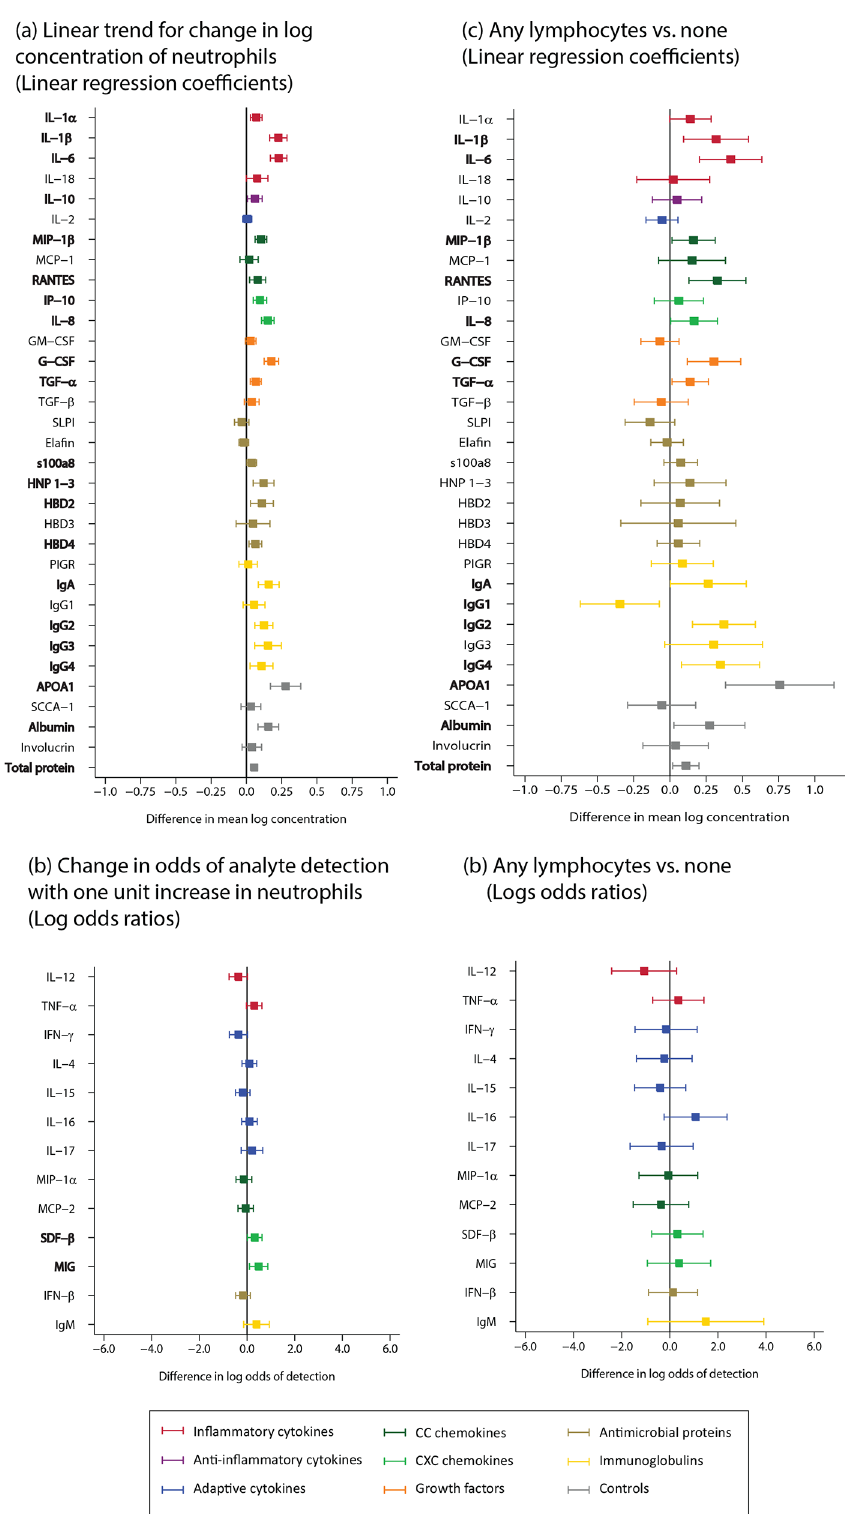
Fig 9. White blood cells (WBCs; neutrophils, n = 361; lymphocytes, n = 361). WBCs from the CVL cell pellet were identified and enumerated. For the statistical analysis, lymphocytes were either present or absent, and neutrophil were categorized as follows: no cells, 1 – 10 cells, 11 – 50 cells, > 50 cells. Bolded